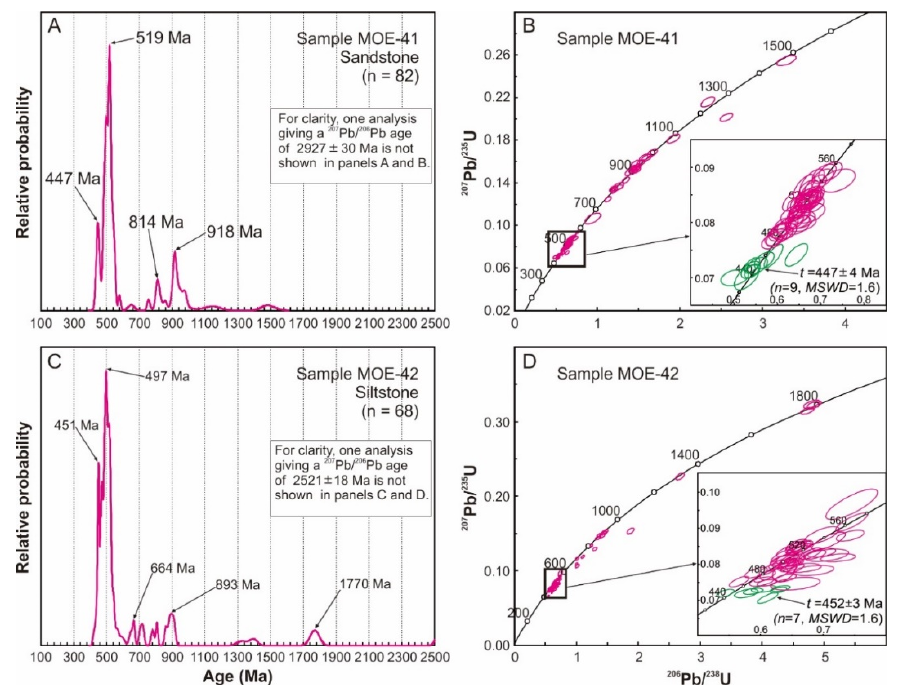
Figure 9. Detrital zircon age-relative probability diagrams ( left ) and concordia diagrams ( right ) for samples MOE-41 ( A , B ) and MOE-42 ( C , D ) from the Paleozoic sedimentary rocks on the Ereendavaa terrane in NE Mongolia.